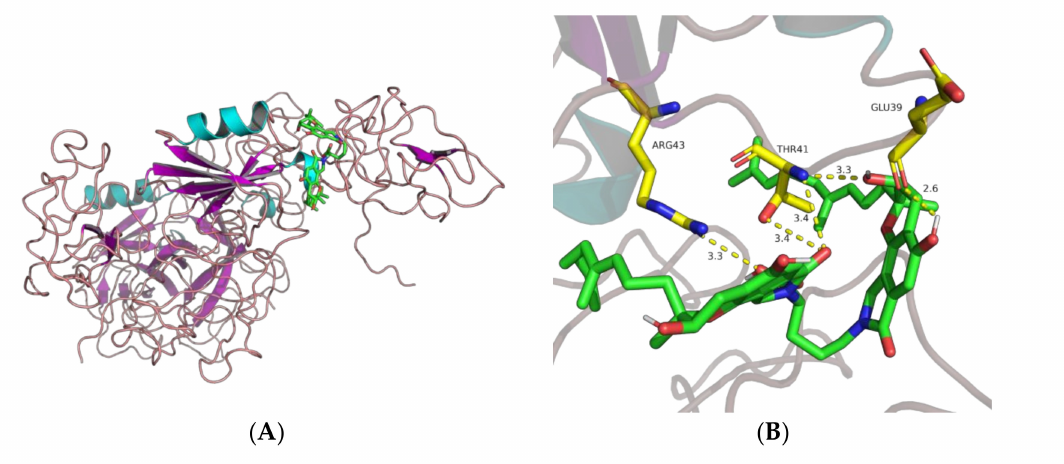
Figure 8. Schematic diagram of optimal conformational interaction between FGFC1 and plasminogen. ( A ) Binding site and ( B ) the 3D model of FGFC1 docking with